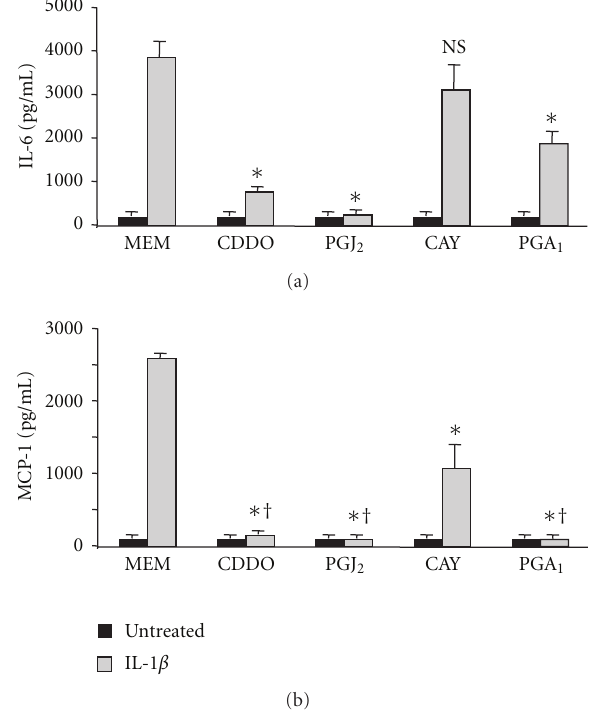
Figure 7: A strong electrophilic carbon is necessary for PPAR γ ligand-mediated attenuation of inflammation in IL-1 β -treated human lung fibroblasts. Primary human lung fibroblasts were pre- treated with 1 μ M CDDO, 5 μ M 15d-PGJ 2 (PGJ 2 ), 5 μ M CAY10410, (CAY) or 15 μ M PGA 1 for 1 hour and then co-treated with 1ng/mL of IL-1 β for 24 hours. Supernatants were harvested, and cytokine concentrations were measured by ELISA. (a) CDDO, 15d-PGJ 2 , and PGA 1 , but not CAY10410, significantly inhibited production of IL-6 ( ∗ P < . 01). (b) CDDO, 15d-PGJ 2 , PGA 1 , and CAY10410 all significantly reduced MCP-1 production ( ∗ P < . 01). CDDO, 15d-PGJ 2 , and PGA 1 were significantly more potent than CAY10410 ( † P < . 01). Results are mean ± standard deviation for quadruplicate wells and are representative of 3 independent experiments.